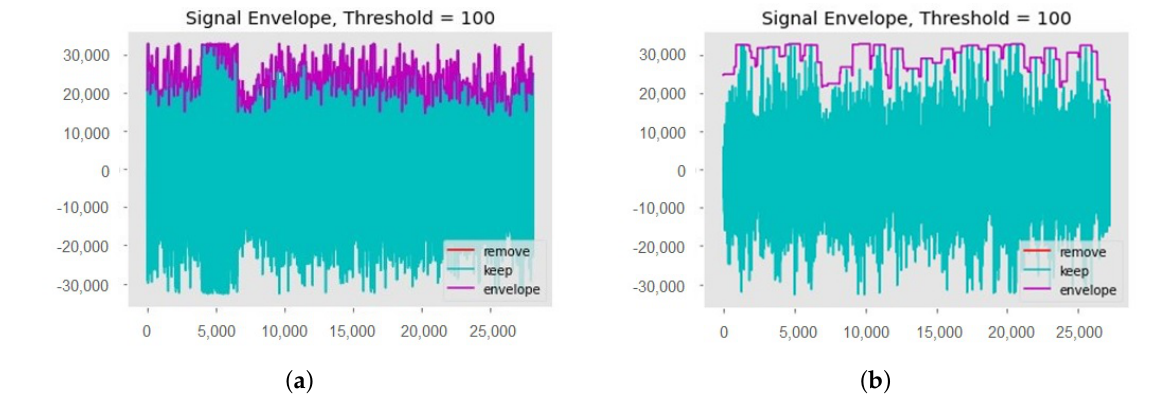
Figure 4. Signal envelope function: ( a ) Signal envelope plot; ( b ) Zoomed portion of the